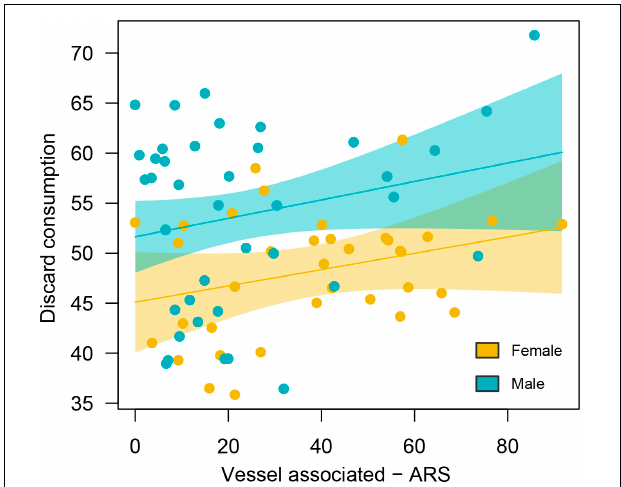
FIGURE 5 | Percentage of area-restricted search (ARS) associated with vessels versus percentage of discard consumption from the same individual. Orange, females; blue,